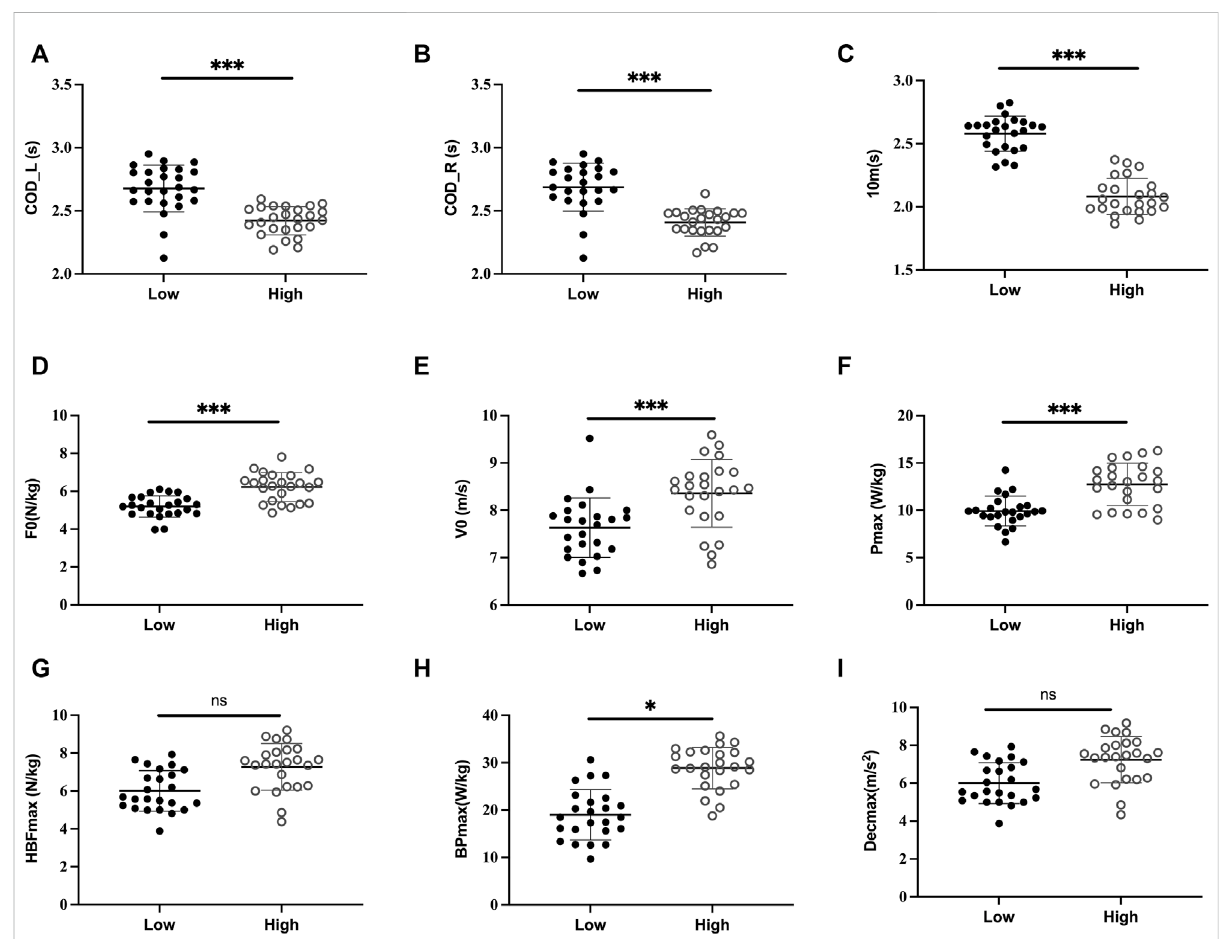
FIGURE 1 Acceleration and deceleration mechanicalparametersand COD performance on theleftside(COD_L) andrightside(COD_R)are displayed by COD performance (High vs. Low) in female soccer players; F0: maximal theoretical force; V0: maximal theoretical velocity; P max : maximal power; 10 m: 10 m split time; HBF max : maximum braking force; HBP max : maximum braking power; Dec max : maximum deceleration; *: p < 0.05; **: p < 0.01; ***: p < 0.001; ns: non-signi fi